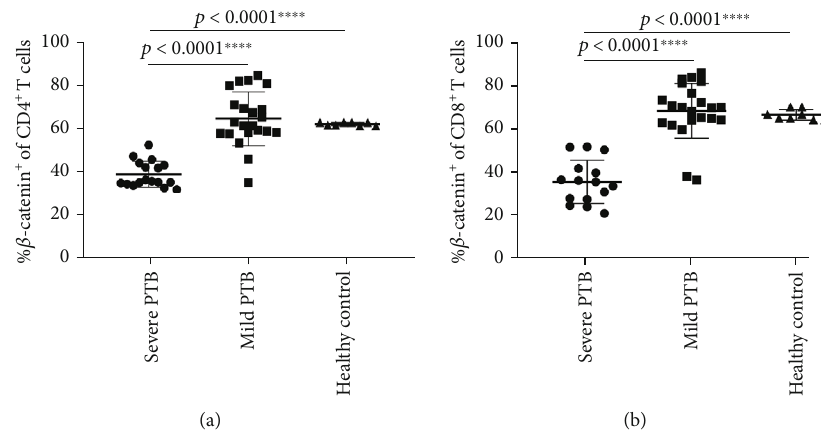
Figure 4: Expression of β -catenin on CD4 + and CD8 + T cells. PBMCs from patients with severe PTB ( n = 17 ), mild PTB ( n = 22 ), and health controls ( n = 8 ), then stained the PBMCs by fl ow cytometry. (a) β -catenin expression in CD4 + T cells. (b) β -catenin expression in CD8 + T cells. Results were analyzed by the unpaired Student t